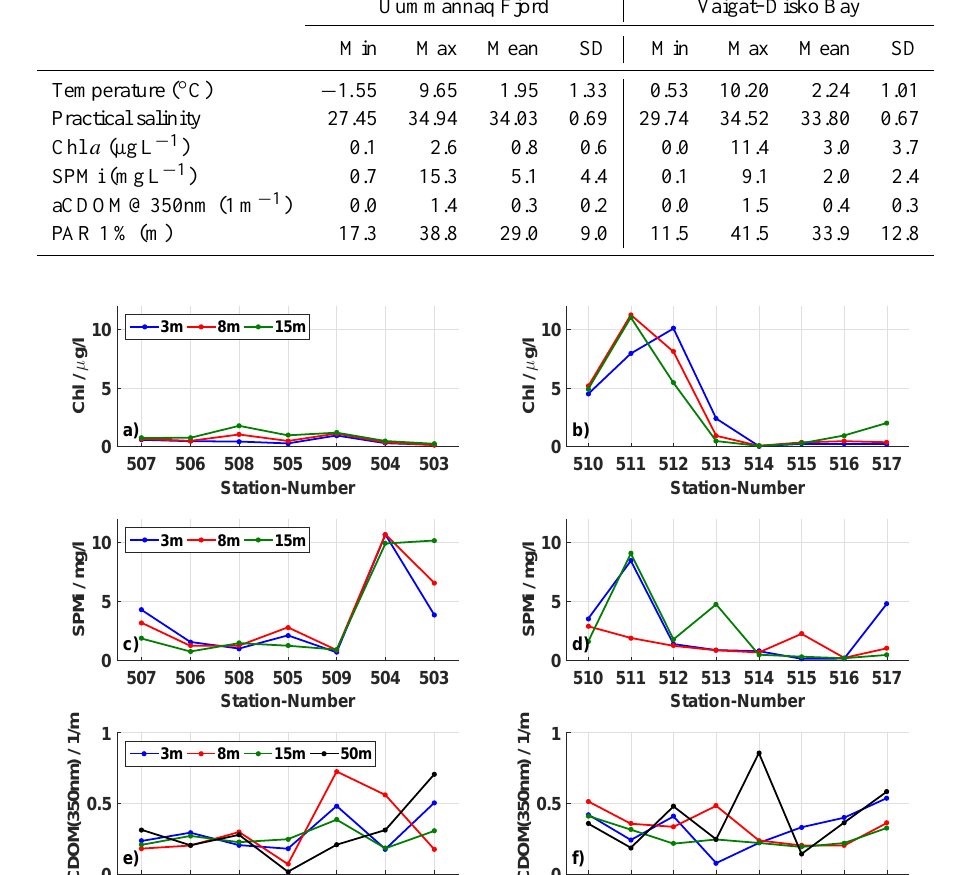
Table 3. Statistics of oceanographic and bio-optical data from Uummannaq Fjord and in Vaigat–Disko Bay. Each column is subdivided into minimum (min), maximum (max), mean and standard deviation (SD).